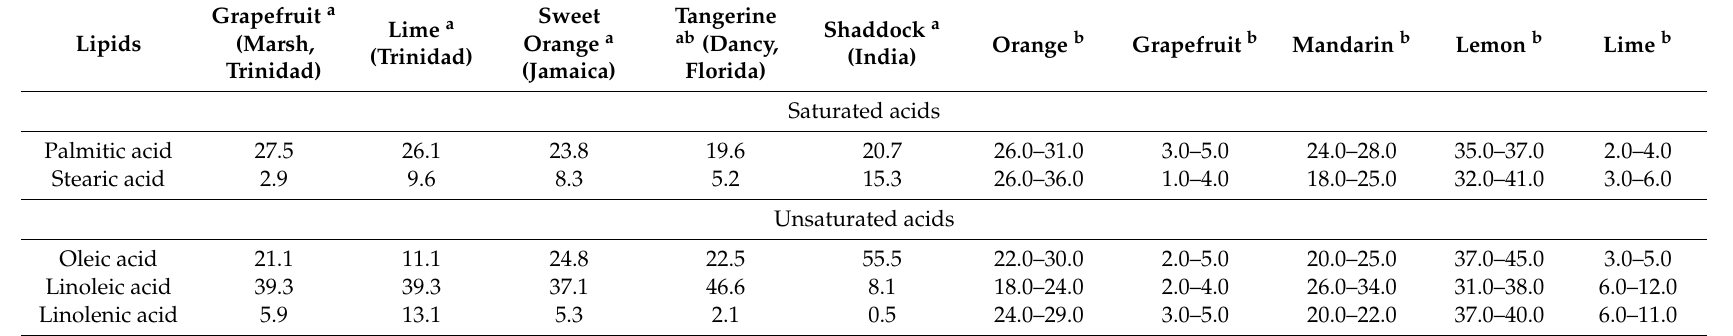
Table 9. Composition of major fatty acids in citrus seeds a [21] and seed oils b [135] (in percentage by weight of total fatty